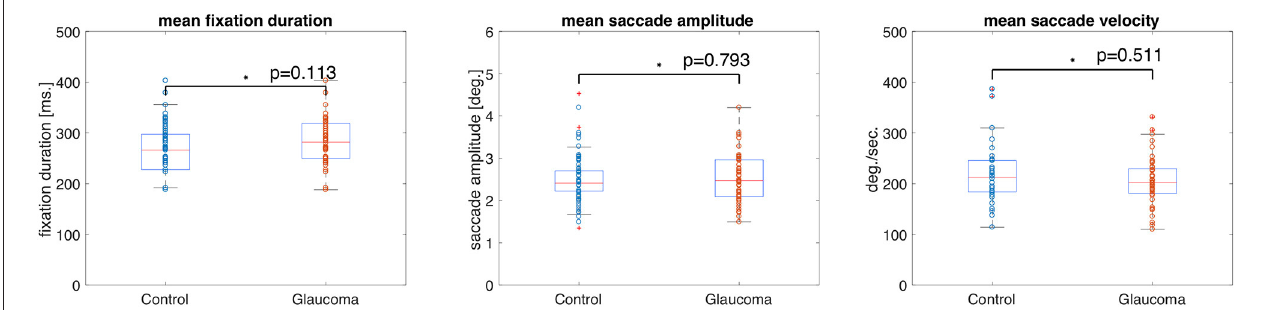
FIGURE 9 | Box and whisker plots showing the mean and variance of four different eye movement features for the control and glaucoma groups. The circles represent the values of the individual participants. The group means did not differ significantly.